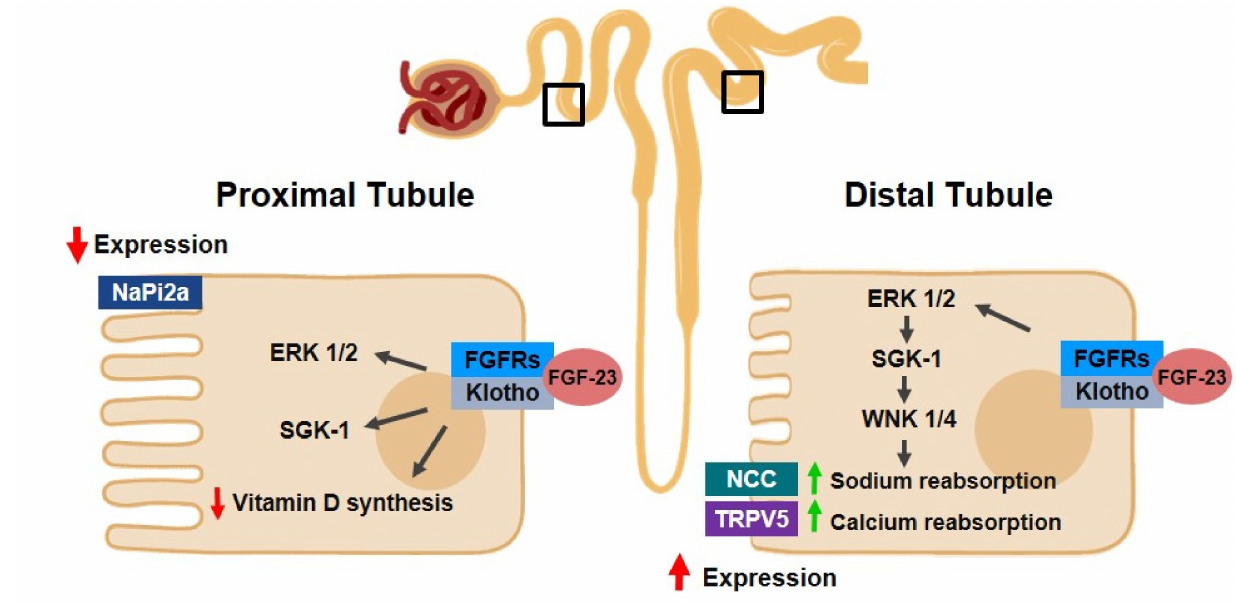
Figure 1. Klotho and FGF23 in mineral homeostasis in kidneys. In proximal tubules, the Klotho/fibroblast growth-factor (FGF) 23/fibroblast growth factor receptors (FGFRs) complex acti- vates extracellular signal-regulated kinase (ERK) 1/2, serum/glucocorticoid-regulated kinase (SGK)-1 and with no lysine kinase (WNK) 1/4 pathways, which results in the reduction of the expression of sodium phosphate co-transporter (NaPi2a), leading to phosphaturia. In distal tubules, in turn, the same complex and signaling pathways are activated and this results in an increase in sodium chloride cotransporter (NCC) and transient receptor potential cation channel subfamily V member 5 (TRPV5) channels, which contributes to increases in both sodium and calcium reabsorption,